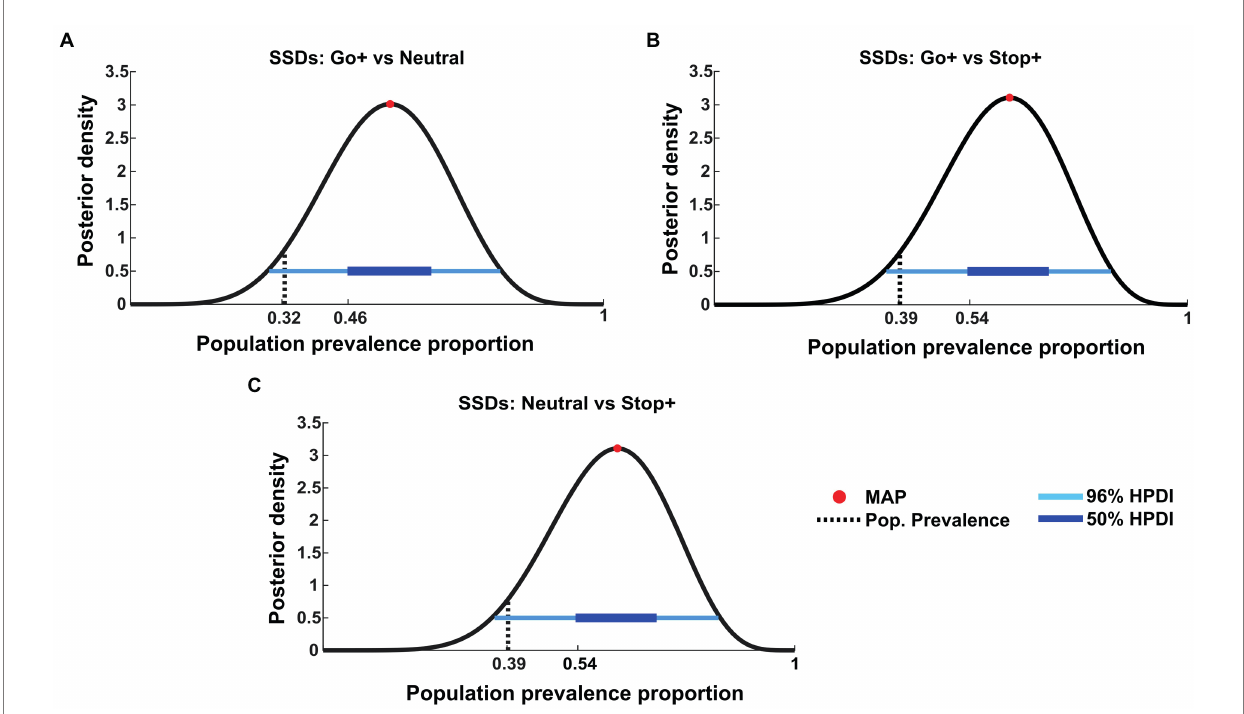
FIGURE 7 Bayesian inference of population prevalence for SSDs. Each panel shows posterior density (black curve) with MAP (red circle), 50% and 96% HPDI (thick/thin blue lines), obtained from within-subject inference at p = 0.05 of RTs for each Cue Condition interaction: (A) SSDs tested on Go+ Condition versus Neutral Condition; (B) SSDs tested on Go+ Condition versus Stop+ Condition; (C) SSDs tested on Stop+ Condition versus Neutral